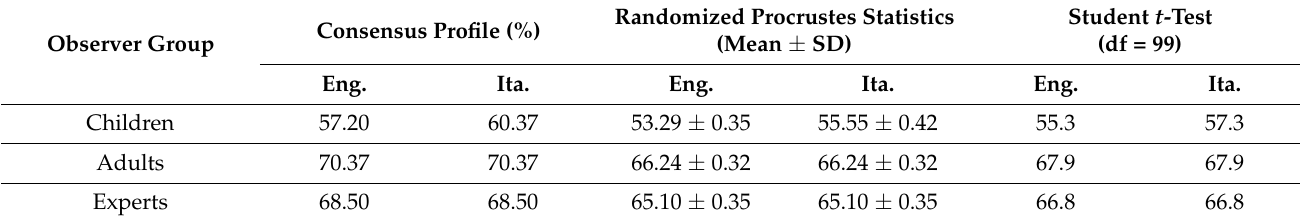
Table 3. Procrustes statistics for the observer groups ( p <